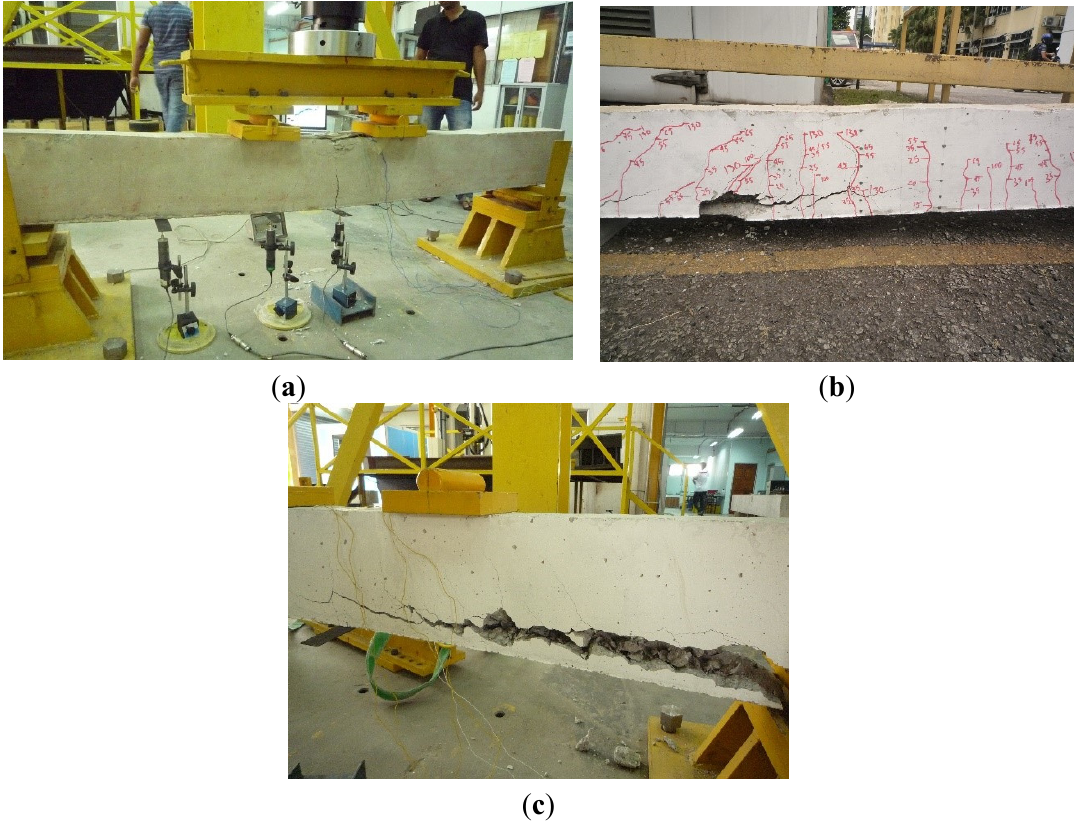
Figure 10. Failure modes of beam CB, A1 and A2. ( a ) Beam CB (concrete crushing failure); ( b ) Beam A1 (concrete cover separation); ( c ) Beam A2 (concrete cover